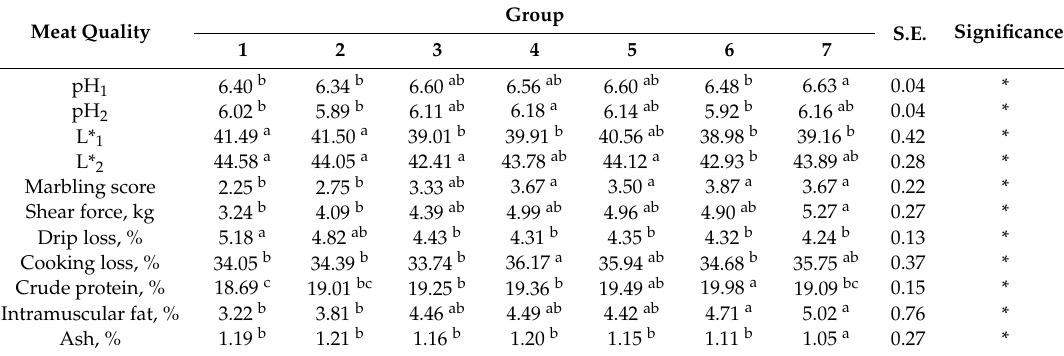
Table 2. Meat quality of Liangshan pig at di ff erent stages. Meat Quality